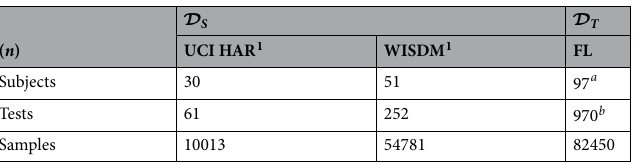
Table 3. Overview of source D S and target domain D T datasets . Datasets were constructed from the original 1 sensor signal using 2.56 [s] epoch sliding windows with a 50% overlap. See supplementary material for more a information on the UCI HAR and WISDM datasets. HC, n=24; PwMSmild, n=52; PwMSmod, n=21; see b demographics Table 1 for more details. Randomly sampling m = 10 tests per